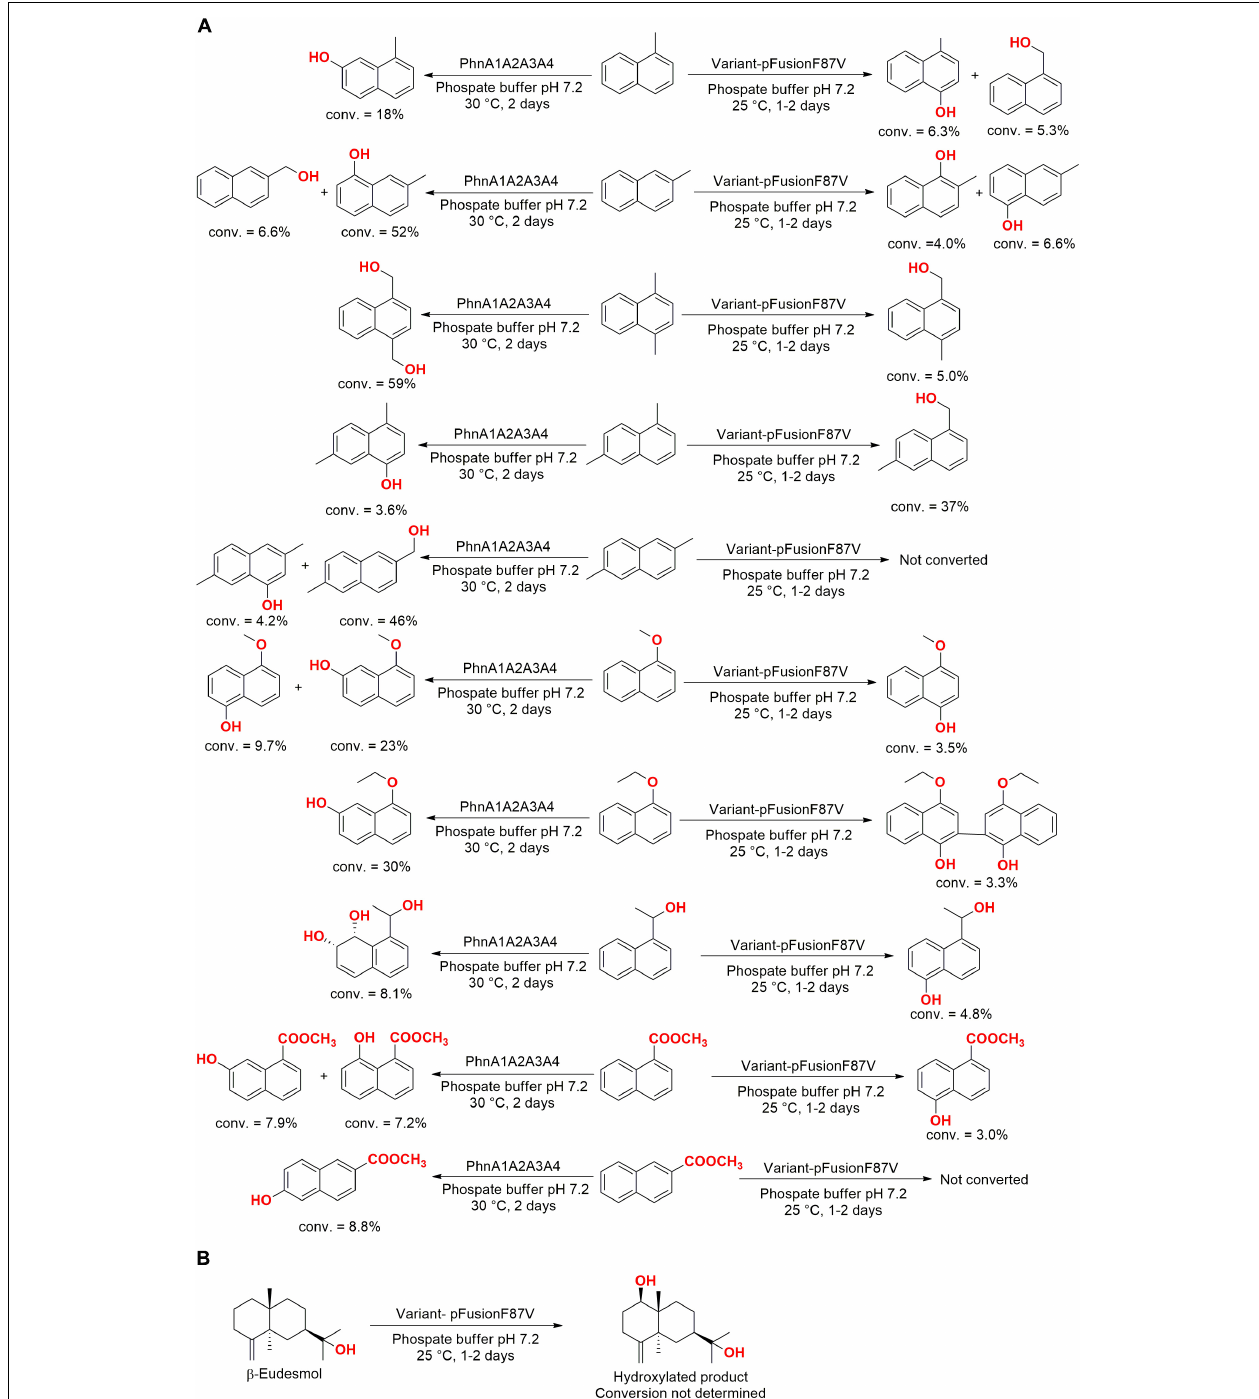
FIGURE 9 | Hydroxylation of (A) naphthalene analogs and (B) β -eudesmol by the enzymes PhnA1A2A3A4 and pFusionF78V overexpressed in E. coli (Misawa et al., 2011).